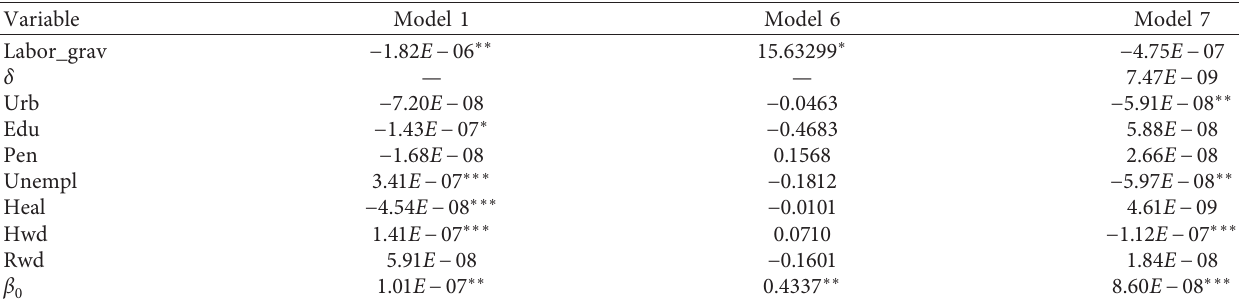
Table 7: The estimation results of 25 provinces and the catching-up index is the mediator variable.